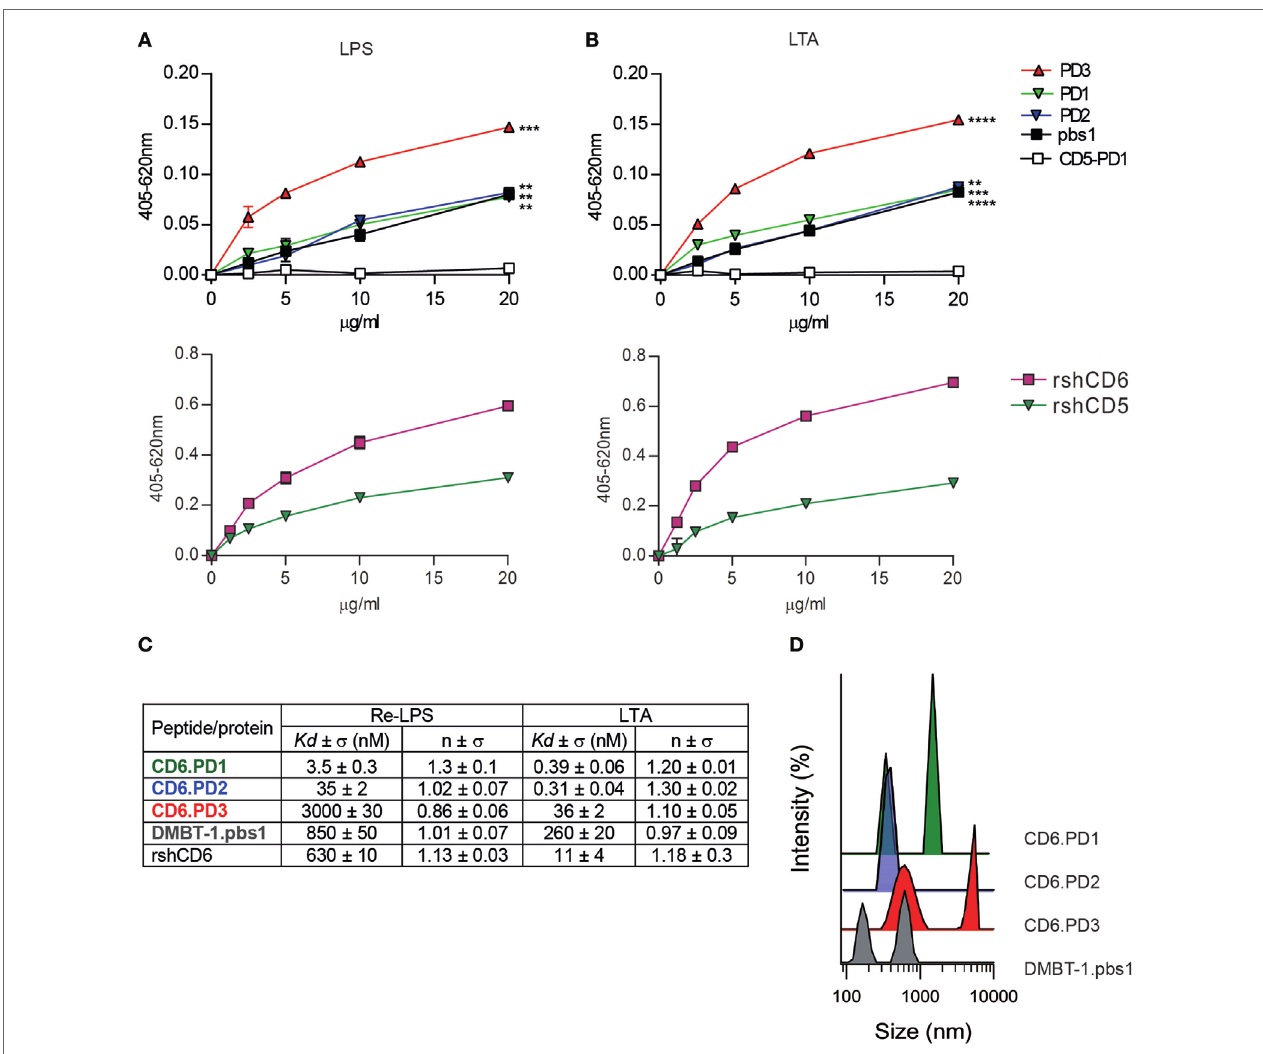
FigUre 3 | Analysis of the direct binding characteristics of CD6-derived peptides to purified pathogen-associated molecular patterns (PAMPs) from Gram-negative and Gram-positive origin. Increasing concentrations (5–20 µg/mL) of biotin-labeled CD6 (PD1, PD2, and PD3), deleted in malignant brain tumors-1 (DMBT-1)/ SAG- (pbs1), and CD5- (PD1) derived peptides (top panel), or rshCD5 and recombinant soluble human CD6 ectodomain (rshCD6) proteins (bottom panel) were added to 96-well ELISA plates sensitized with lipopolysaccharide (LPS) ( a) or lipoteichoic acid (LTA) (B) . Following overnight incubation at 4°C bound peptides or proteins were developed by addition of horseradish peroxidase–streptavidin and 3,3’,5,5’-tetramethylbenzidine substrate and further readings at OD 405–620 nm. Results are expressed as mean ± SD of duplicates from one representative experiment of three performed. Statistical analysis was performed by two-way ANOVA (* P < 0.05; ** P < 0.01; and *** P < 0.001). (c) Apparent K d values and Hill coefficients for the binding of peptides and proteins in study to LPS and LTA determined by tryptophan fluorescence. Peptides and proteins (10 µg/mL) were titrated with or without increasing concentrations of LPS or LTA in phosphate buffered saline (PBS). Results are mean ± SD of three experiments. (D) Dynamic light scattering analysis of the hydrodynamic diameter of CD6 (PD1, PD2, and PD3) and DMBT-1/ SAG (pbs1)-derived peptides (10 µg/mL) in PBS. The y axis represents the relative intensity of the scattered light; the x axis denotes the hydrodynamic diameter of the particles present in the solution. One representative experiment of four is